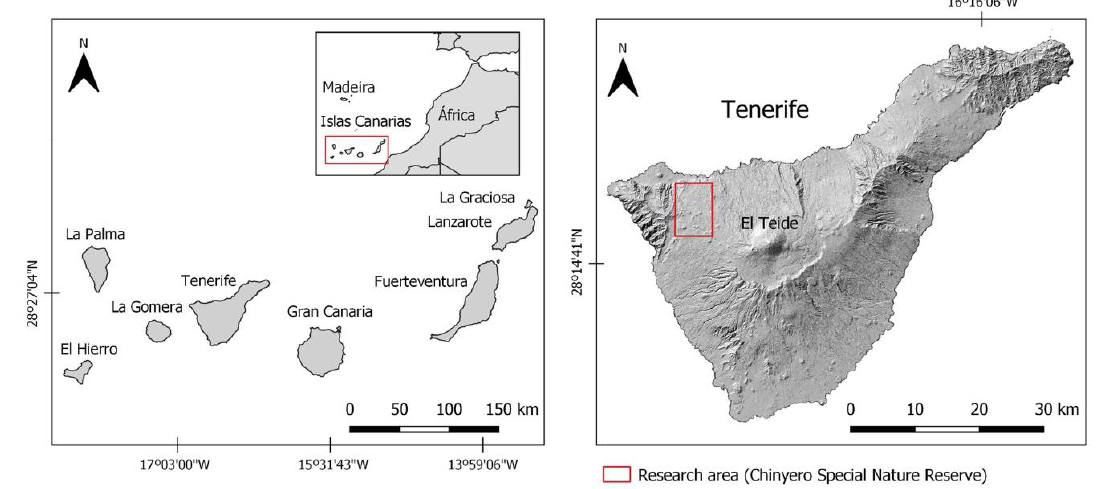
Figure 3. Location of the Chinyero Special Nature Reserve. Source: IDE-Canarias, self-elaboration.